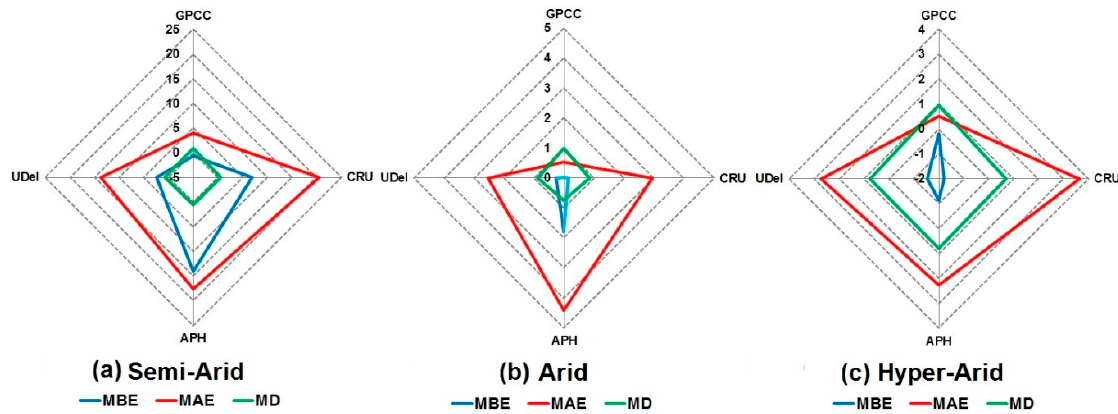
Figure 11. Multivariate diagrams showing a statistical summary of precipitation data at ( a ) semi-arid ( b ), arid, and ( c ) hyper-arid ( b ), arid, and ( c ) hyper-arid station.